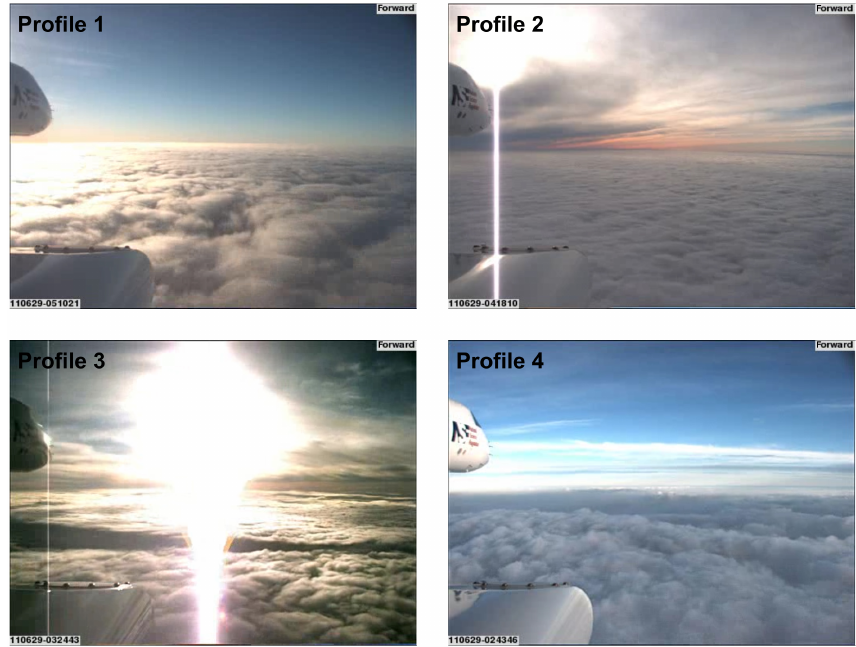
Figure 3. Forward camera imagery of boundary layer cloud top conditions for the four profiles as